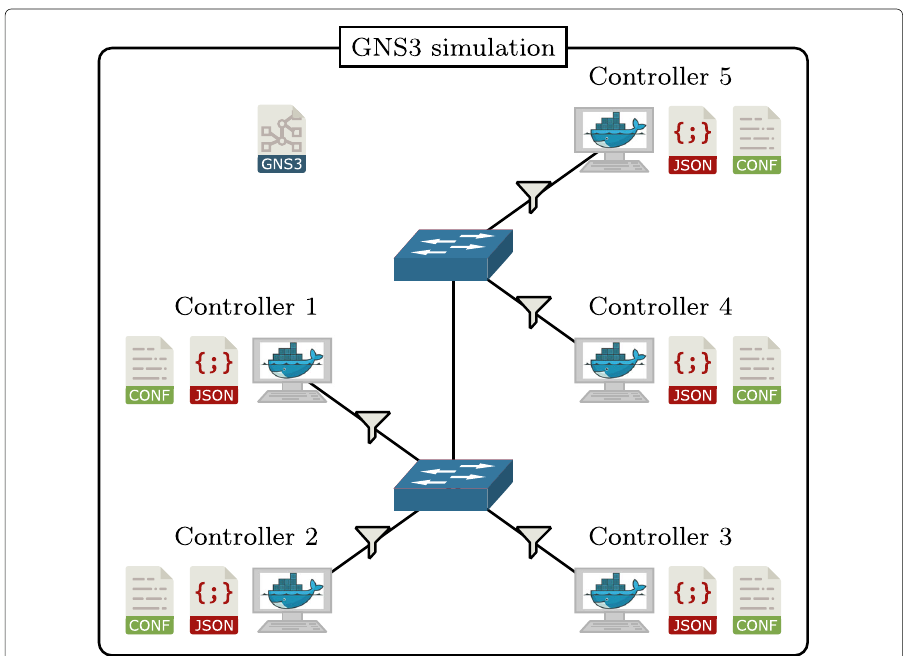
Fig. 3 The diagram displays the structure of a GNS3 simulation with its devices and their configuration files. Every controller is instantiated from the same Docker image which contains the implementation of the distributed OPF. Network filters are applied on all network cables connecting the controllers with the